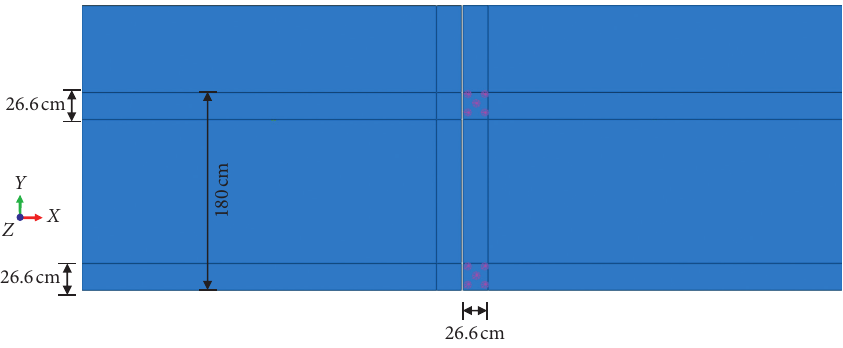
Figure 2: The shape and position of the vehicle load on the slab of FEA